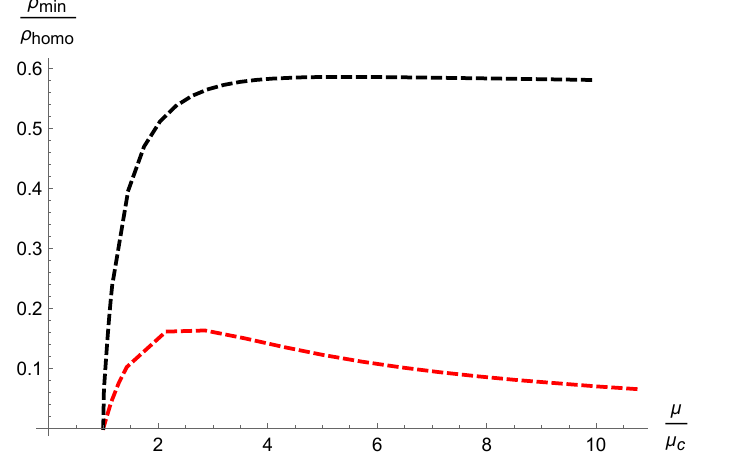
Figure 6 . The speci(cid:12)c value of density (cid:26) min =(cid:26) homo with respect to the relative chemical potential (cid:22)=(cid:22) c for the standard (black dashed) and alternative (red dashed) quantizations.